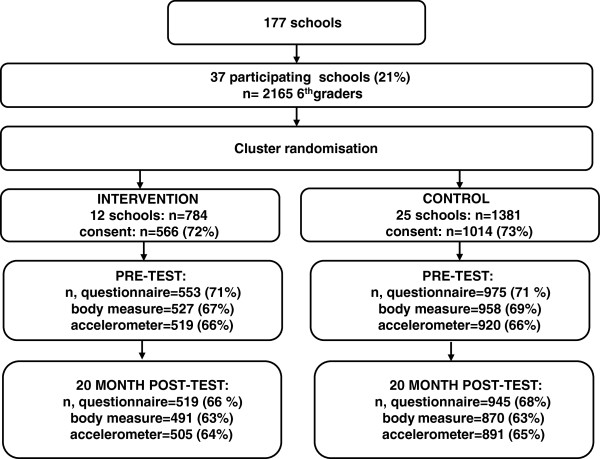
Flow diagram of recruitment, randomization and participation of adolescents in the HEIA study.